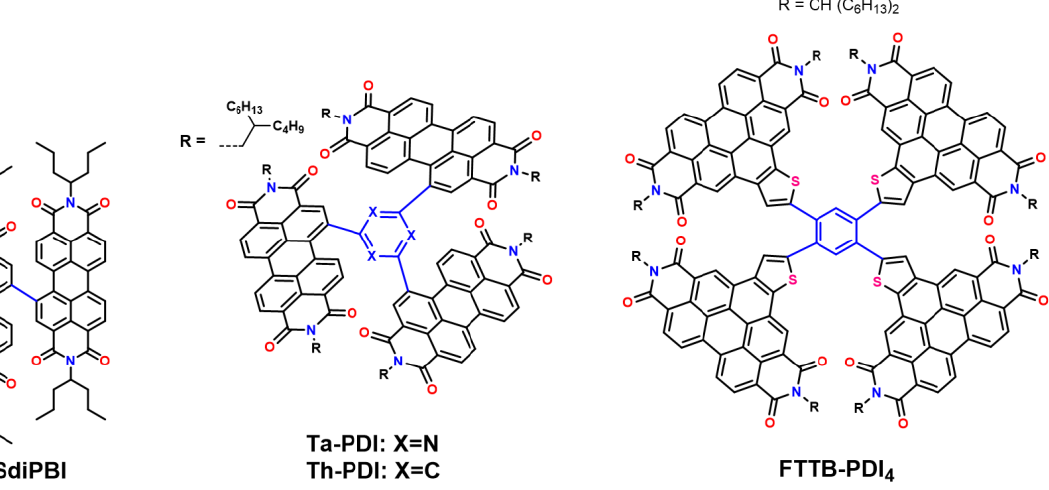
Figure 3. Chemical structures of selected example of PDI monomer [74,75], PDI dimer [79], PDI trimer [78], and PDI tetramer [72] NFAs used in OPV devices.